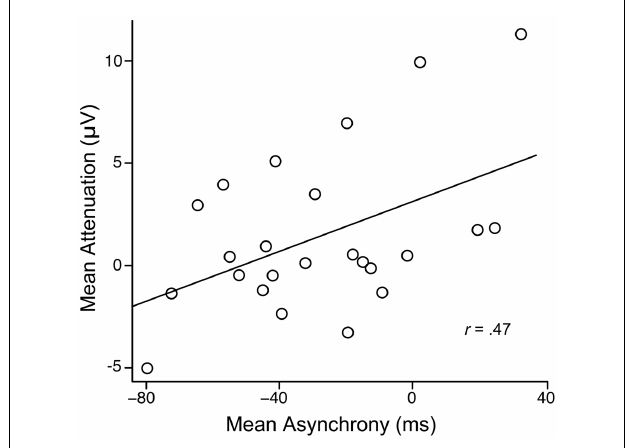
FIGURE 3 | Mean attenuation as a function of the mean asynchrony between participants’ and partners’ button presses in the joint